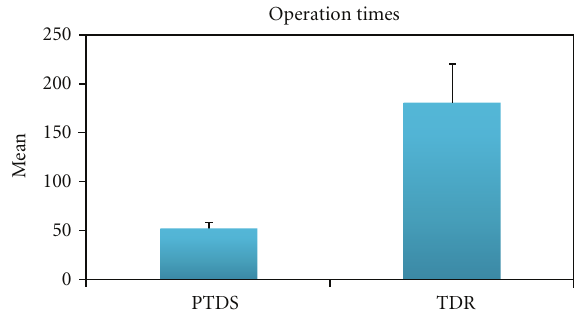
F 5: e data of operation times for both